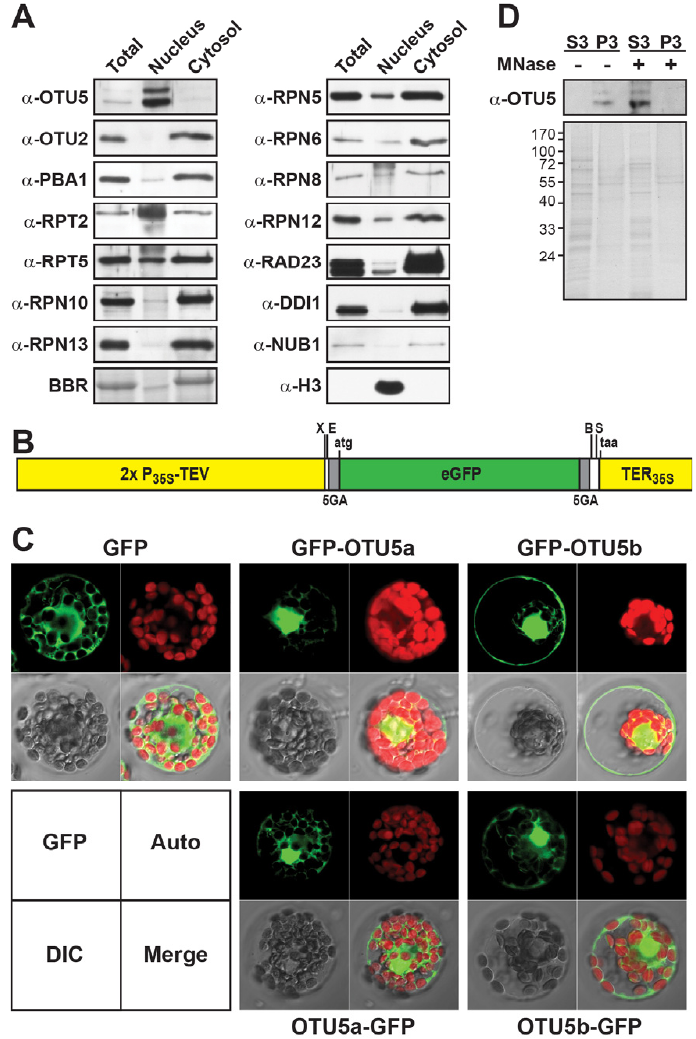
Figure 6. The A. thaliana OTU5a and OTU5b proteins are nucleus-enriched and chromatin-associ- ated. ( A ) The relative abundance of two OTU proteins, various proteasome subunits, and ubiquitin shuttle receptors in total, nuclear, and cytosolic protein fractions prepared from 10 DAS Col-0 seed- lings was examined by immunoblotting with various antisera, as indicated. Antisera against histone H3 ( α -H3) were analyzed to verify the purity of the nuclear fraction. Equal amounts of proteins from each fraction were analyzed. Duplicate samples were stained with BBR to show loaded pro- teins. ( B ) Constructs of green fluorescence protein (GFP) fusions used for transient expression were built in p2X35S-TEV-eGFP-35ST (see Section 4), with relevant components shown schematically. The restriction sites used for N- and C-terminal fusions were Xma I (X)/ Eco RI (E) and Bam HI (B)/ Sal I (S), respectively. Two linker sequences encoding five GA repeats (5GA) were designed to preserve